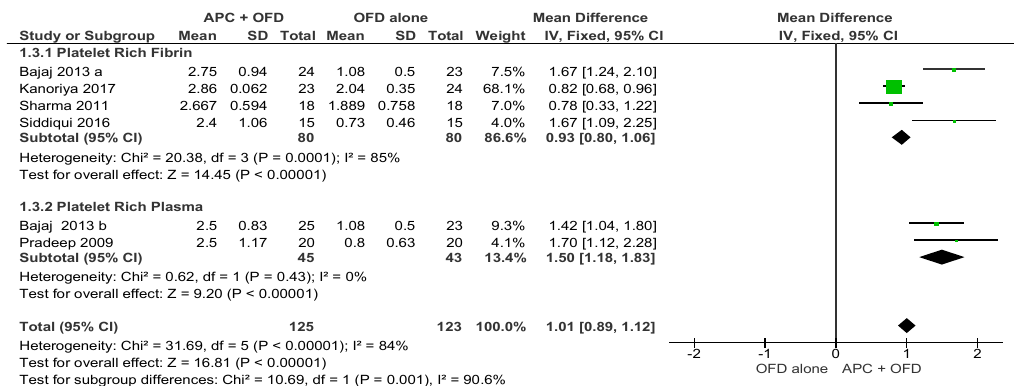
APC + BG vs. BG Alone (Figure 8)